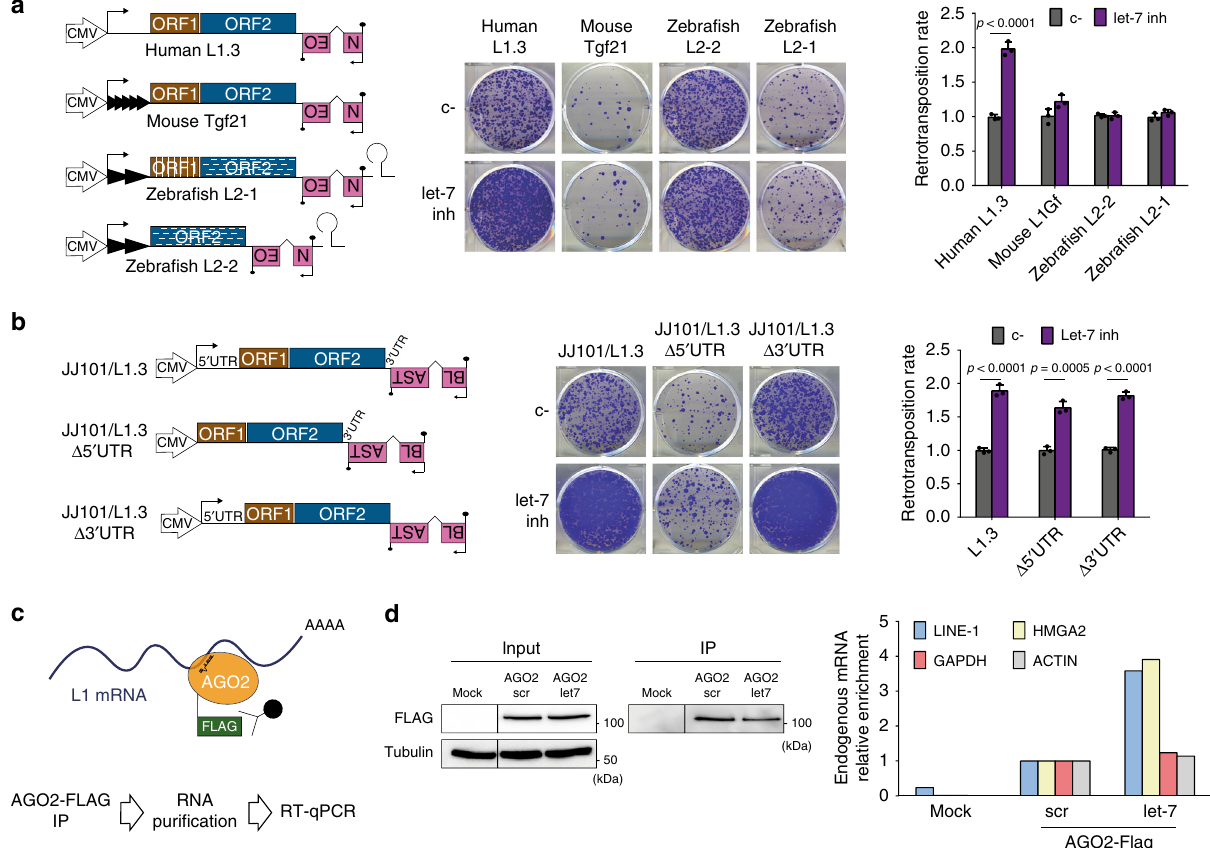
Fig. 3 Let-7 binds directly to the coding sequence of L1 mRNA. a Cell culture-based retrotransposition assay using mneoI reporter cassette. HeLa cells were co-transfected with LINEs from different species and let-7 inhibitor or its control (c-). All constructs have an exogenous CMV promoter to normalized transcription. Black arrows represent transcription start sites. Gray triangles in mouse and zebra fi sh LINEs illustrate the presence of monomers in the 5 ′ UTR of these elements. Stem loop (gray) pictures the hairpin structures present in the 3 ′ UTR of the zebra fi sh LINE-2s, required for retrotransposition. White stripes are included to remark the differences in sequence of zebra fi sh L2-2 and L2-1 with respect to the human L1.3 and mouse L1G F . A representative well is shown in the middle panel. Quanti fi cation is shown on the right as average ± s.d of three biological replicates. b Cell culture-based retrotransposition assay with blasticidicin resistance cassette. HeLa cells were co-transfected with LINEs lacking either the 5 ′ or the 3 ′ UTR (structures shown in the left) and let-7 inhibitor or its control (c-). A representative well of three replicates is shown. Quanti fi cation is shown at the right as average of three replicates ± s.d. In ( a – b ), an unpaired two-tailed t test was used to calculate p value, and statistically signi fi cant exact p values are shown. Source data are provided as a Source Data fi le . c Scheme of RNA Immunoprecipitation (RIP) of AGO2-FLAG and RT-qPCR analysis of endogenous mRNA enrichment upon let-7 overexpression. Embryonic teratocarcinoma cells (PA-1) were co-transfected with a plasmid to overexpress AGO2-FLAG and let-7 mimic. AGO2-FLAG (orange circle with green fl ag) was immunoprecipitated with a FLAG antibody (black circle and lines), and the RNA bound to AGO2 (L1 mRNA is shown in blue) was puri fi ed and analyzed by RT-qPCR. Transfection with pBSKS (empty vector) was used as a negative control. d Real-time RT- qPCR analysis of endogenous L1 mRNA upon immunoprecipitation of AGO-2-FLAG of one representative experiment of three replicates. Left panel: loading controls are shown for input and IP. Right panel: mRNA relative enrichment upon let-7 overexpression: LINE-1 (blue), HMGA2 (yellow), GAPDH (red), and ACTIN (gray) are